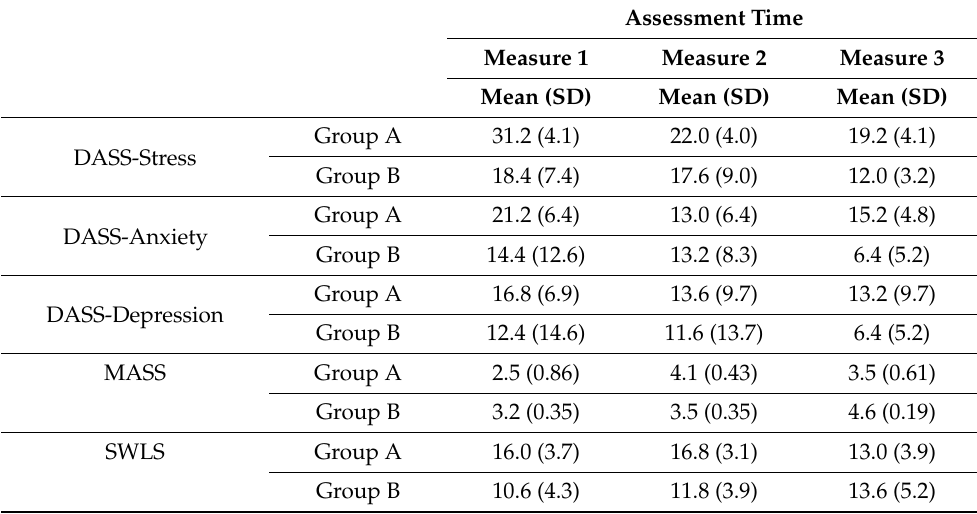
Table 3. Means and standard deviations of the three scales of the DASS-21, MASS and SWLS for the two groups in the three assessed measurement times.